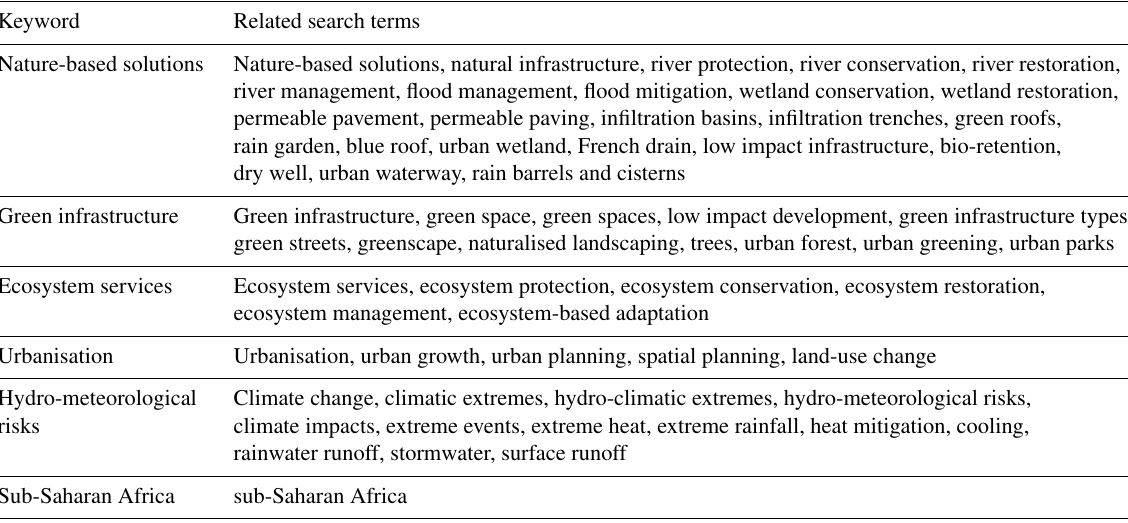
NB: Table S1 contains the specific terms used for each database